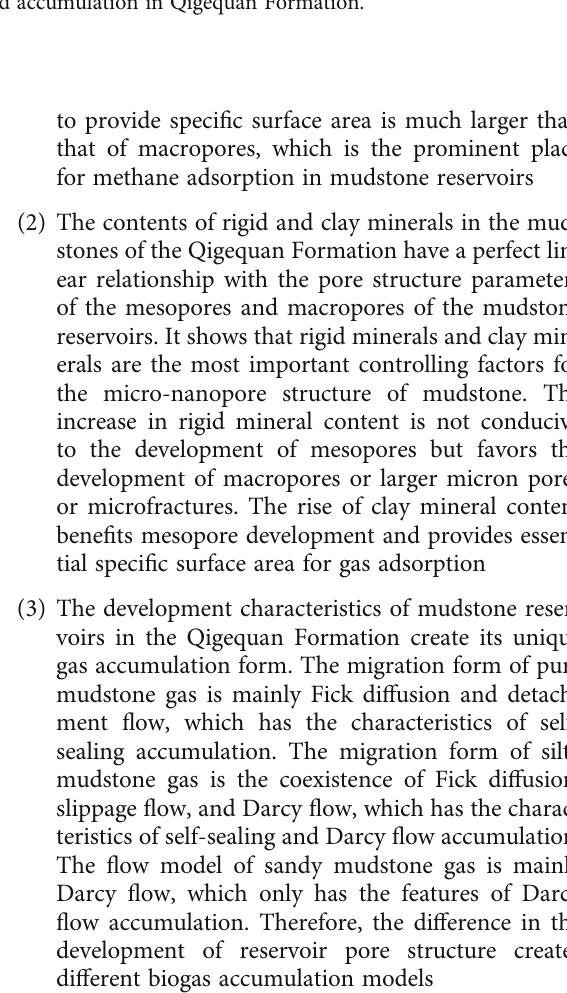
Figure 16: Model fi gure of biogas enrichment and accumulation in Qigequan